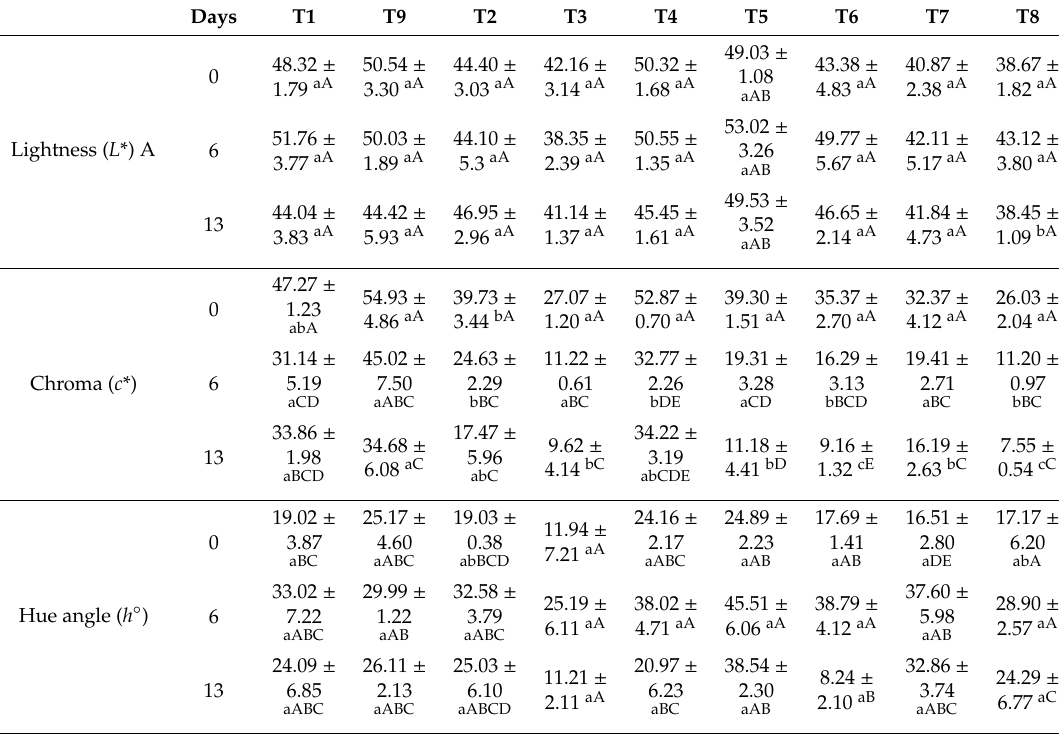
Table 7. E ff ect of antioxidants on L *, c * and h ◦ parameters of raw beef patties during refrigerated storage (4 ± 1 ◦ C).